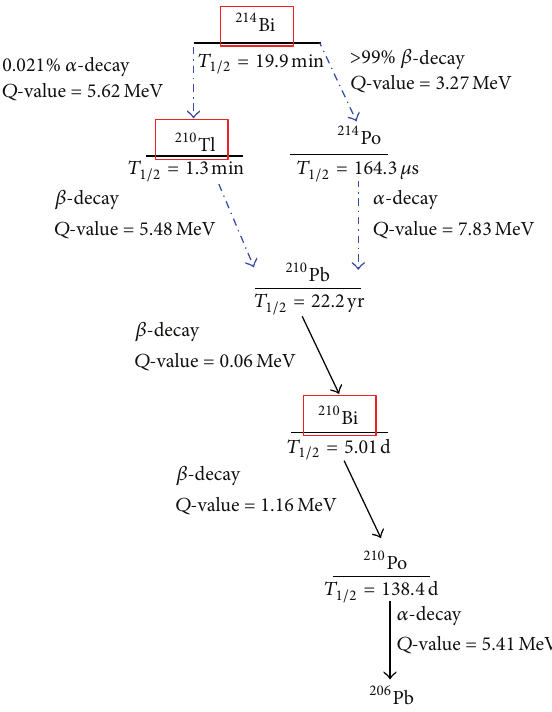
Figure 3: Part of 238 U-decay chain relevant for SNO+ with 𝑄 - values (total kinetic energy released in the ground state-ground state transition), half-life, and decay modes [24]. The red squares highlight the nuclides of most concern: 214 Bi, 210 Tl, and 210 Bi. The decays used for 𝛼 - 𝛽 and 𝛽 - 𝛼 coincidence techniques are shown with a blue arrow (dash-dotted line).